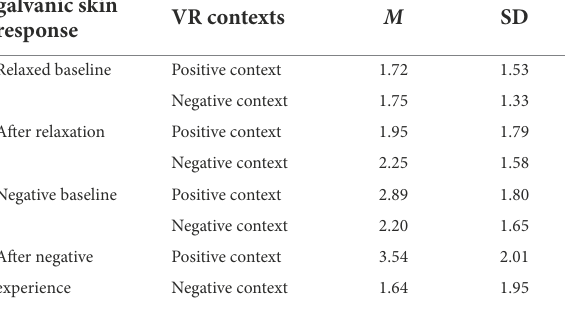
TABLE 4 Galvanic skin response under different VR